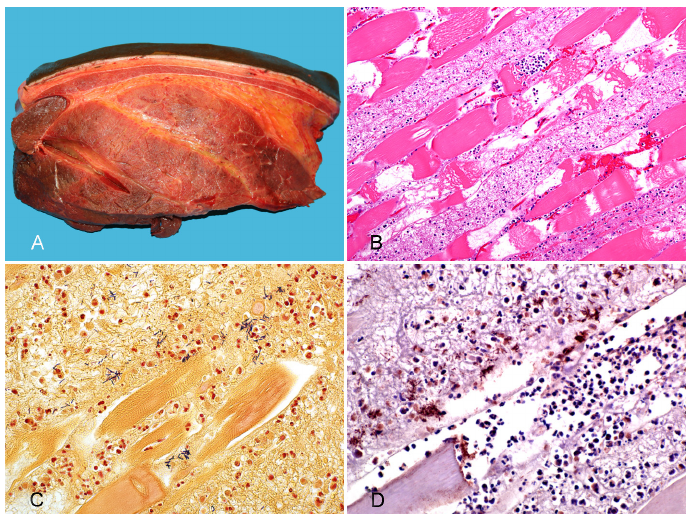
Figure 3. Tissues from a horse with gas gangrene produced by Paeniclostridium sordellii . ( A ) Severe subcutaneous and interstitial edema. ( B ) Coagulative necrosis, hemorrhage, edema, and neutrophil infiltration in skeletal muscle; HE. ( C ) Clusters of Gram-positive rods in necrotic skeletal muscle. Gram stain. ( D ) Intralesional strong positivity to P. sordellii in affected skeletal muscle. P. sordellii IHC. Reprinted with permission from ref. [40]. Copyright 2019 J Vet Diag